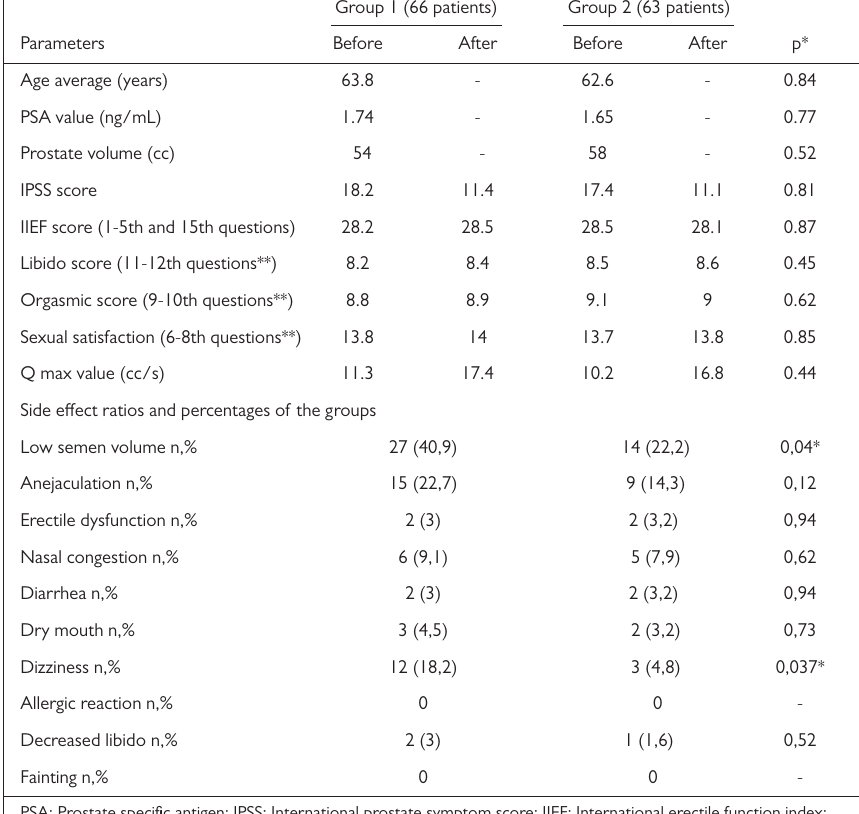
Table 1. Comparison of the parameters and side effects between the